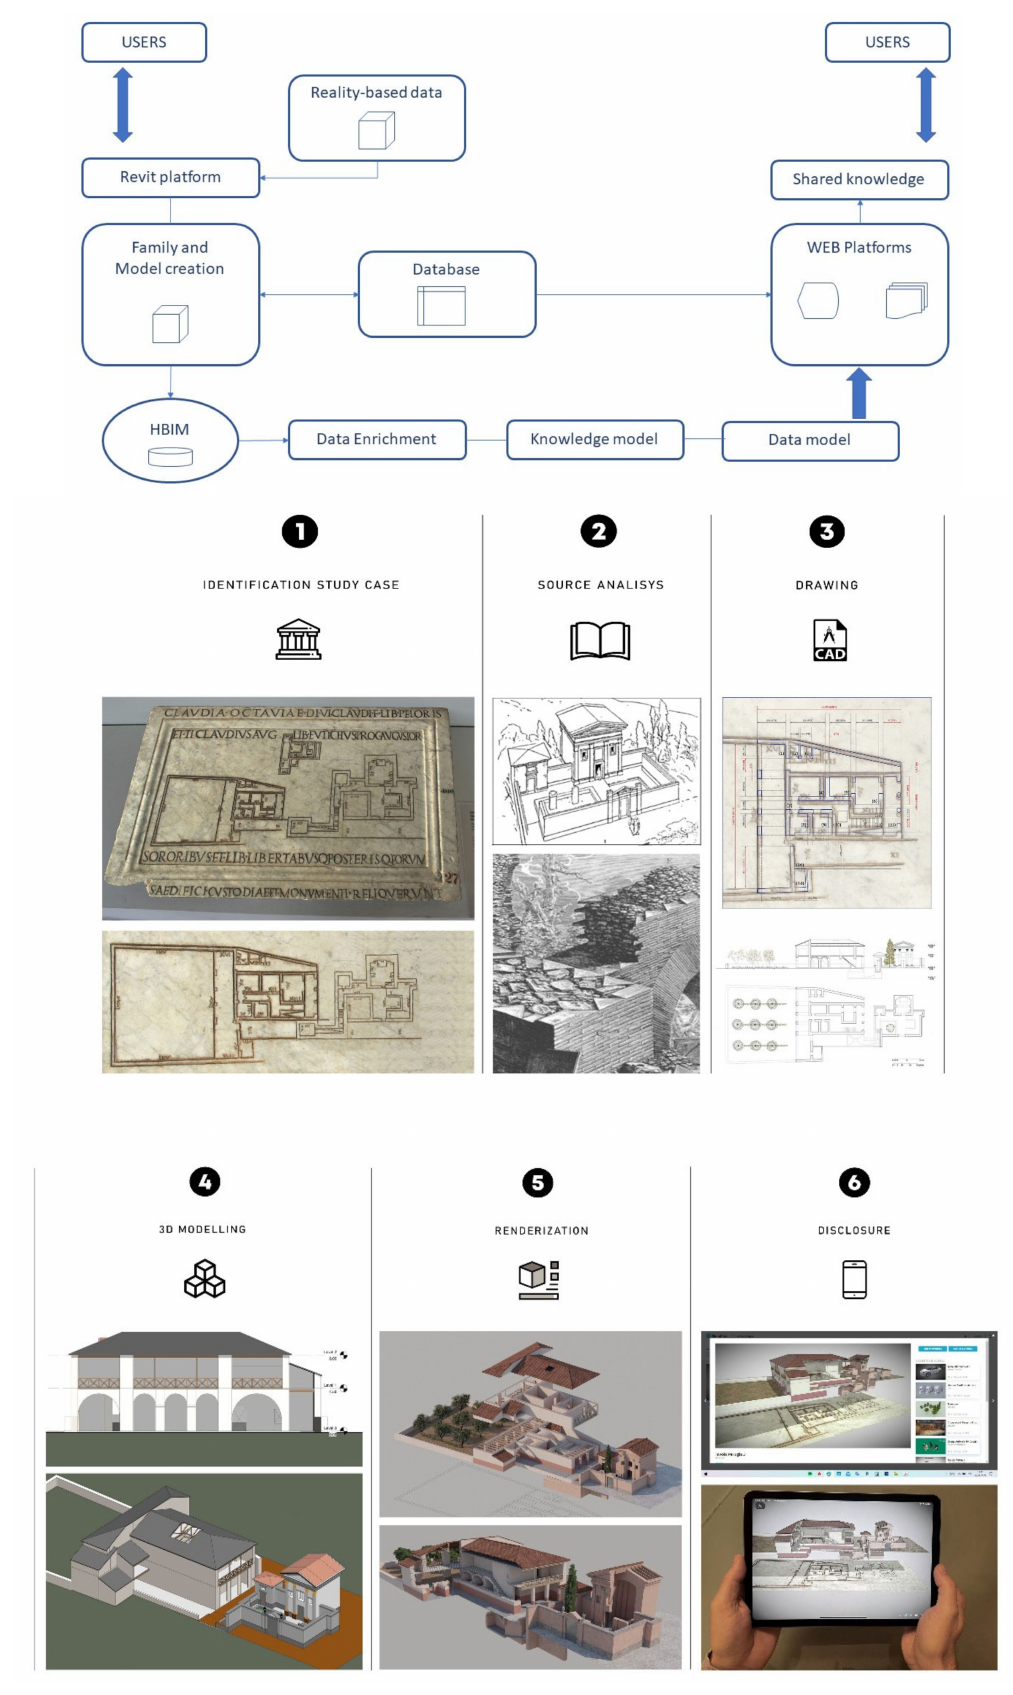
Figure 10. Schema of the